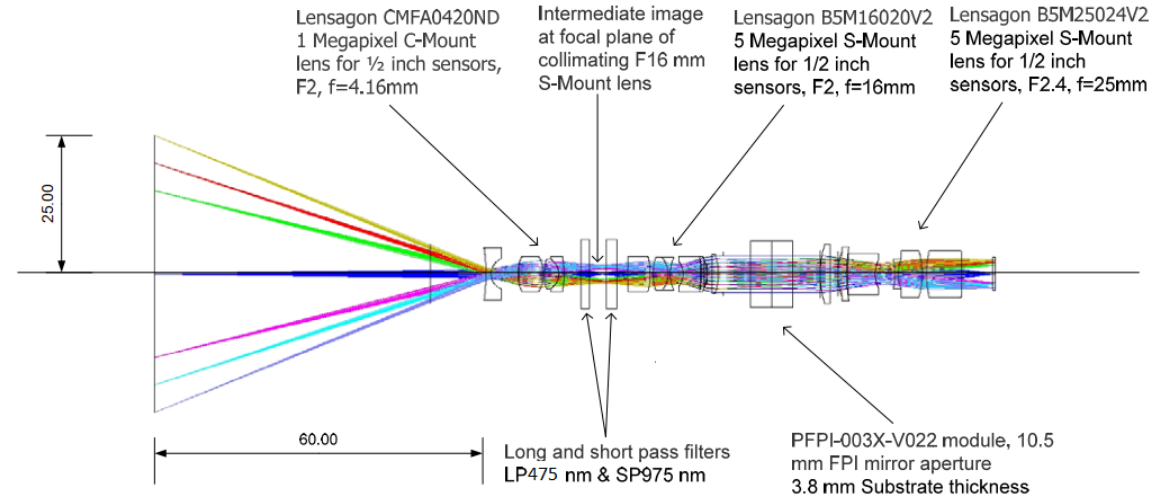
Figure 4. Optical concept of the imaging system of the SICSURFIS Spectral